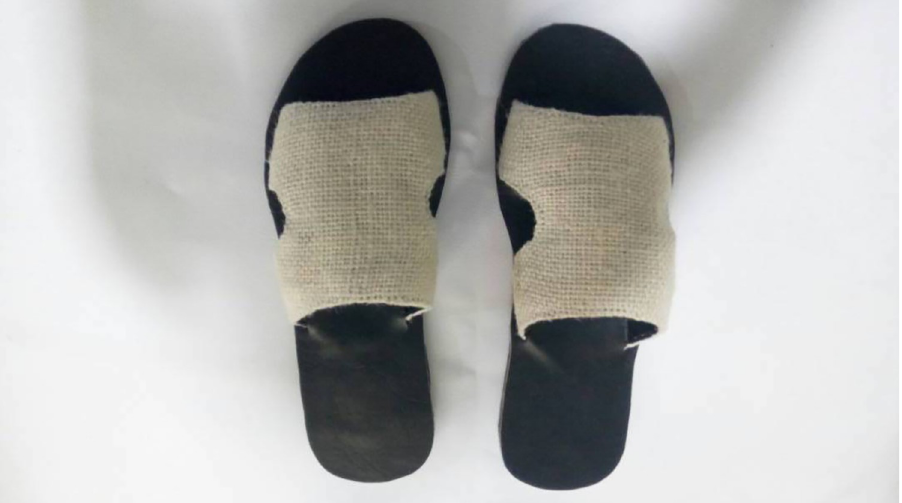
Fig 2. A pair of transfluthrin-treated